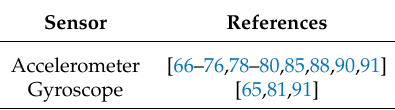
Table 8. Types of sensors used by the identified mobile